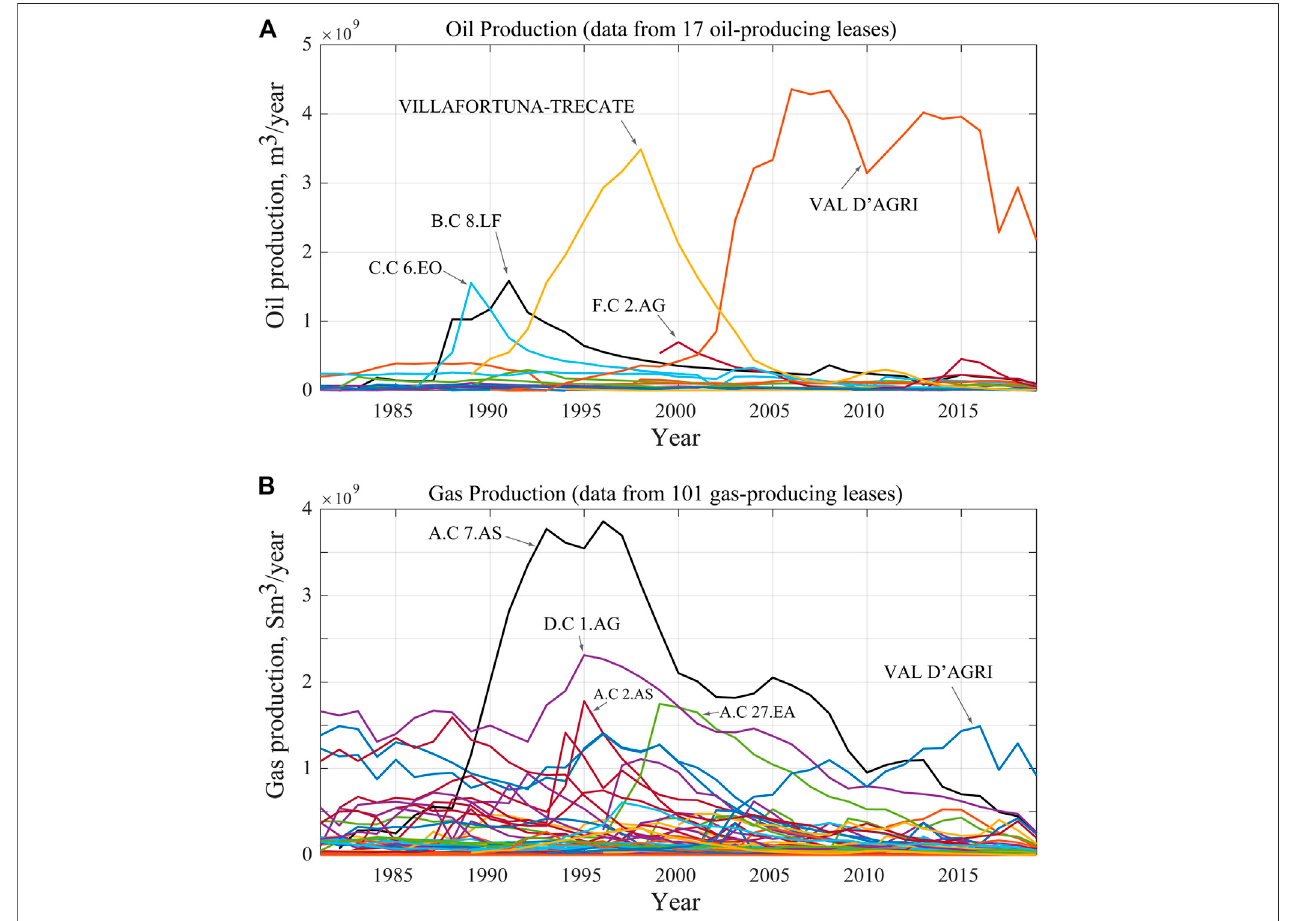
FIGURE 3 | Annual oil and gas produced between 1980 and 2017 in Italy from 102 development leases in Italy: (A) Oil is produced from 17 leases (one of which exclusively produces oil); (B) Gas is produced from 101 leases (85 of which exclusively produce gas). Data available from the Italian Ministry of Economic Development